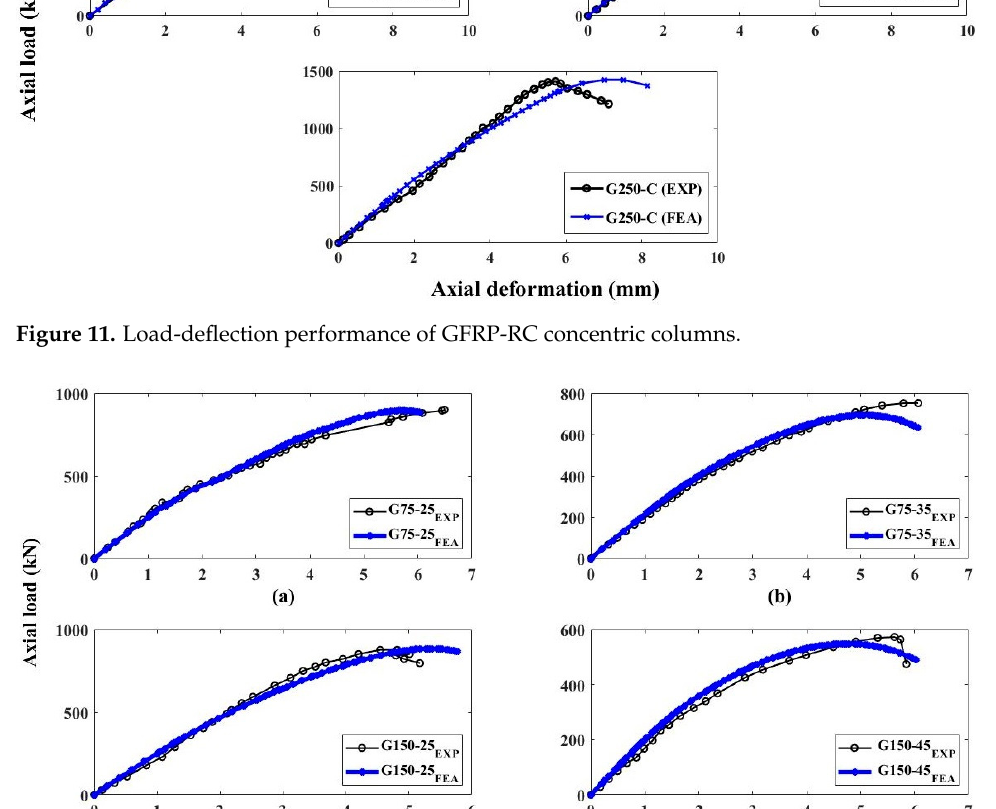
Table 5. Ranges of the parameters during the parametric investigation.